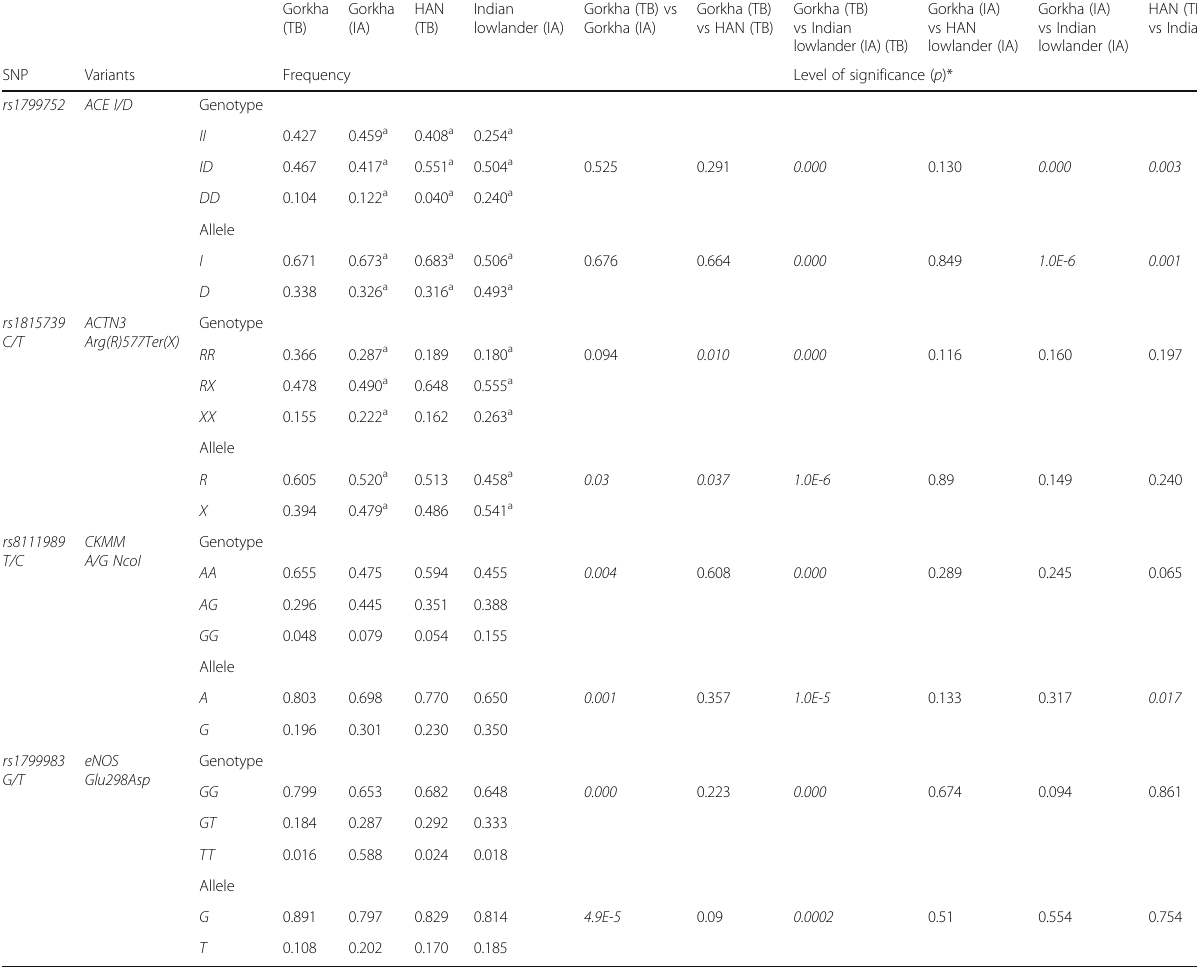
Table 6 Comparison of genotypic and allelic frequencies of studied polymorphisms in male soldiers belonging to Gorkha (TB), Gorkha (IA), HAN (TB) and Indian lowlander (IA) Gorkha Gorkha (TB) (IA)